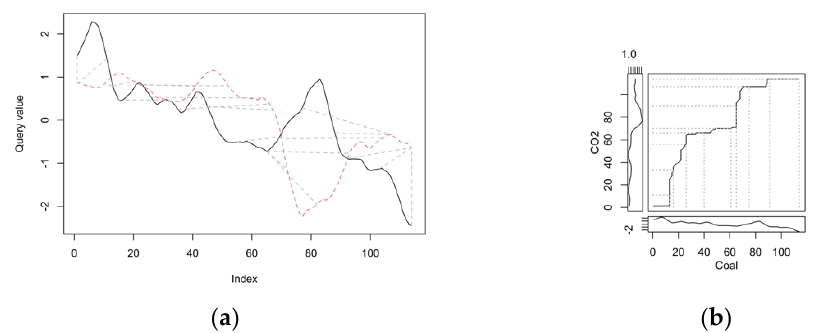
Figure 9. Alignment plots for coal and CO 2 allowances for the first subperiod. ( a ) Two-way, ( b ) Three-